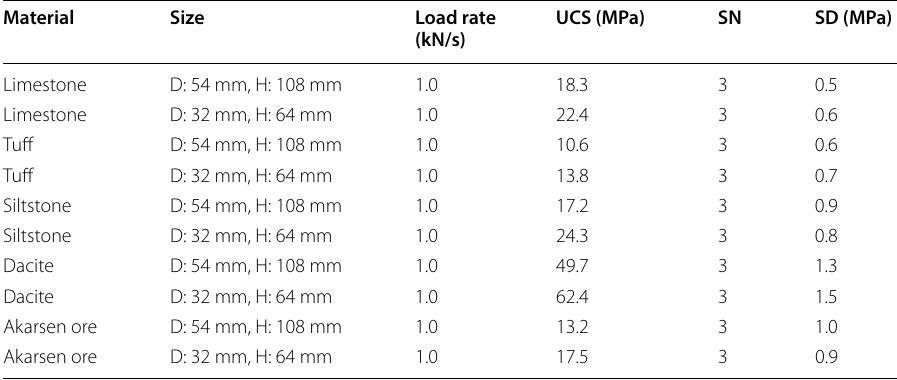
Table 3 Results of tests with load controlled rate selection